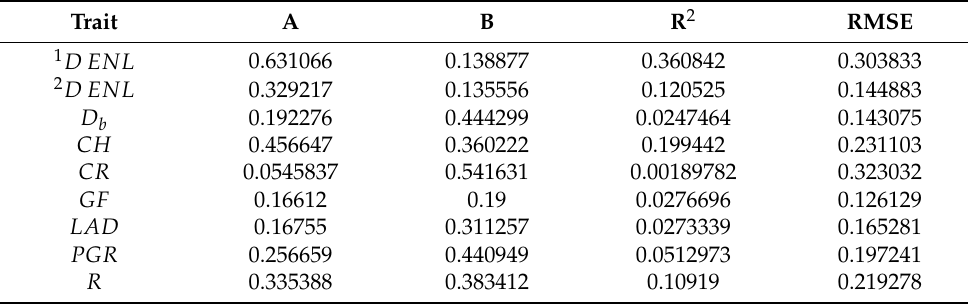
Table A5. Overview linear regression between TLS and ULS at 0.5 m grid